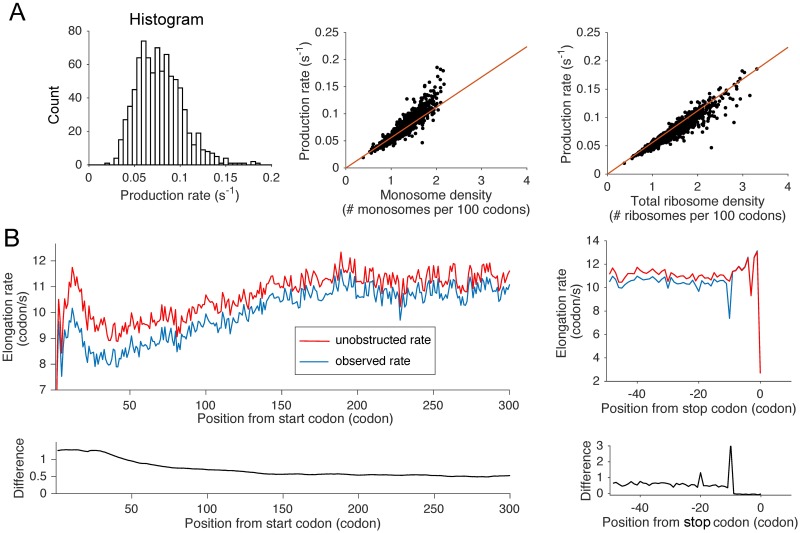
The impact of ribosomal interference on translation dynamics.A. Analysis of protein production. (Left) A histogram of protein production rates. (Middle) Comparison between the protein production rate and the detected-ribosome density obtained from simulations. In red, we plotted the simulated production rate as a function of ribosome density. The red line corresponds to the production rate when we assume no interference and a constant elongation speed of 5.6 codons/s, which was measured experimentally [7]. (Right) Comparison between the production rate and the total ribosome density density obtained from simulations. B. (Left) Position-specific elongation rates averaged over all transcript sequences, aligned with respect to the start codon. Plotted are the inferred unobstructed rate (in red) and the observed rate (in blue). The bottom plot shows the difference between the two curves. (Right) Similar plots as the ones on the left, when the transcript sequences are aligned with respect to the stop codon position.